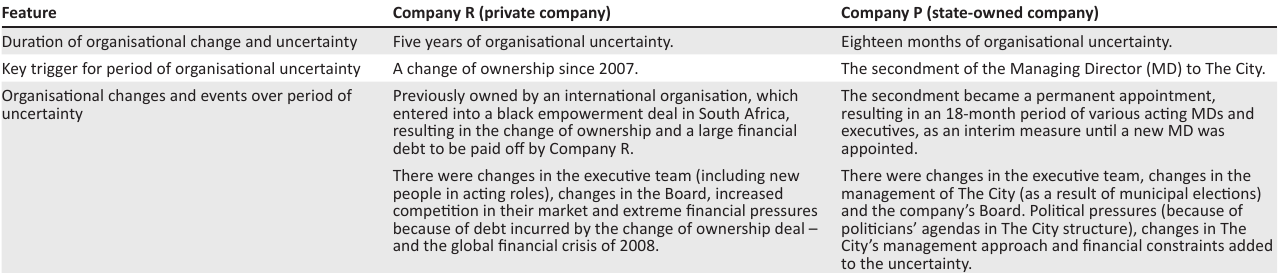
TABLE 1: The context of organisational change and uncertainty in each company. Feature